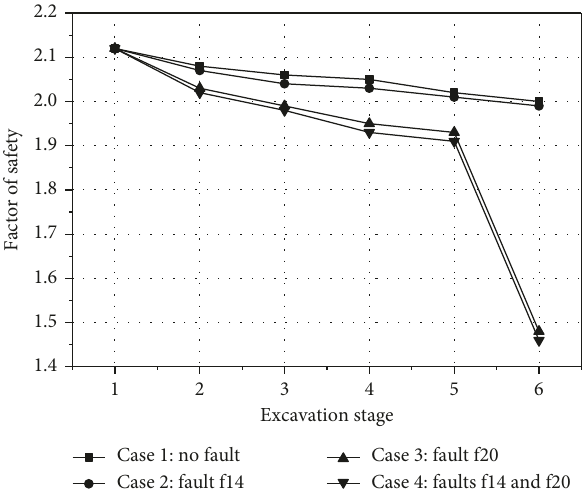
Figure 4: Changes of the FOS of the rock slope with different fault conditions during excavation.